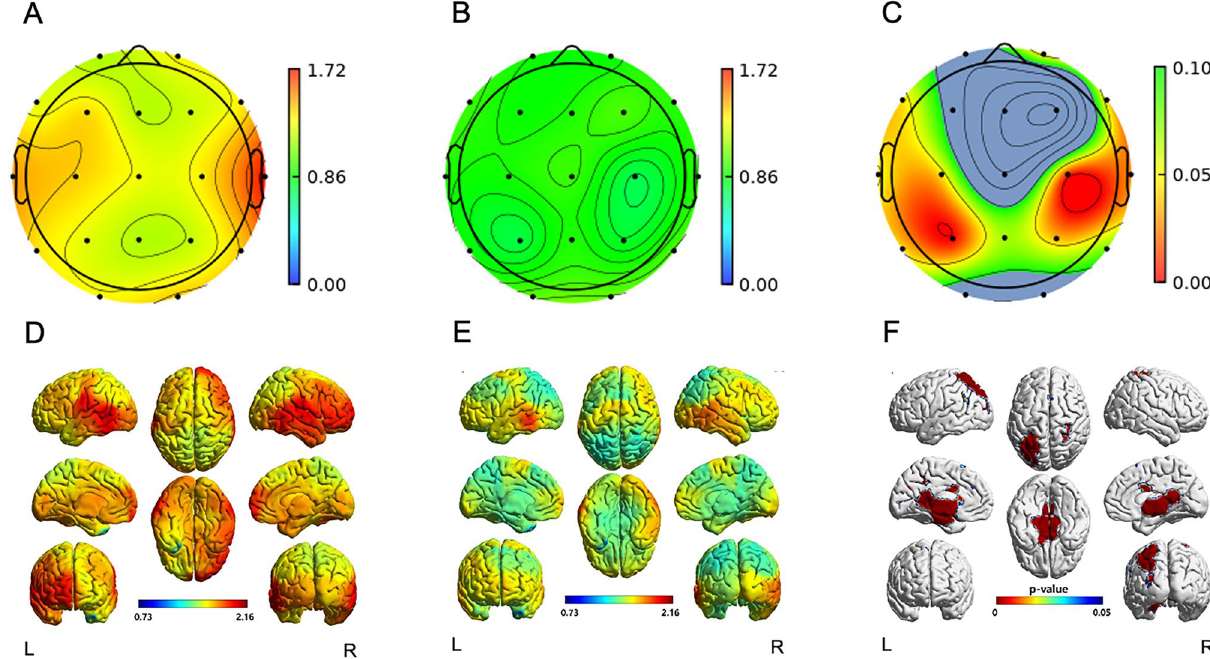
Figure 2. Topomap and 3D view of the ratio of TB2R at 48-week to baseline. Topomap of the control group ( A ), treatment group ( B ). Topomap of p-value from comparison between the control and treatment group ( C ). 3D view of control group ( D ), treatment group ( E ). 3D view of voxel with significant difference between the control and treatment group ( F ). The individual EEG channels are presented as black dot in the topomap ( A ~ C ). Color scale bar means ratio of TB2R at 48-week to baseline in ( A ), ( B ), ( D ), ( E ) and p-value in ( C ) and ( F ). In the ( C ), brain regions of P > 0.10 were shown in gray color. In the ( F ), brain regions of P < 0.05 were colored. The treatment group showed significant decrease of TB2R at bilateral frontotemporoparietal channels after 48 weeks compared to the control group ( C ). Significant decrease of TB2R was observed at the left parahippocampal cortices, bilateral posterior and isthmus part of the cingulate cortex, and the left superior parietal cortex in the treatment group after 48 weeks ( F ). L Left, R Right, TB2R Theta/Beta2 power